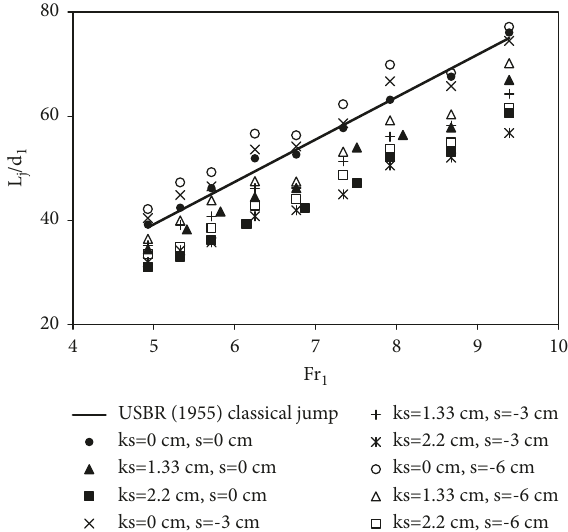
d ) as a function j / 1